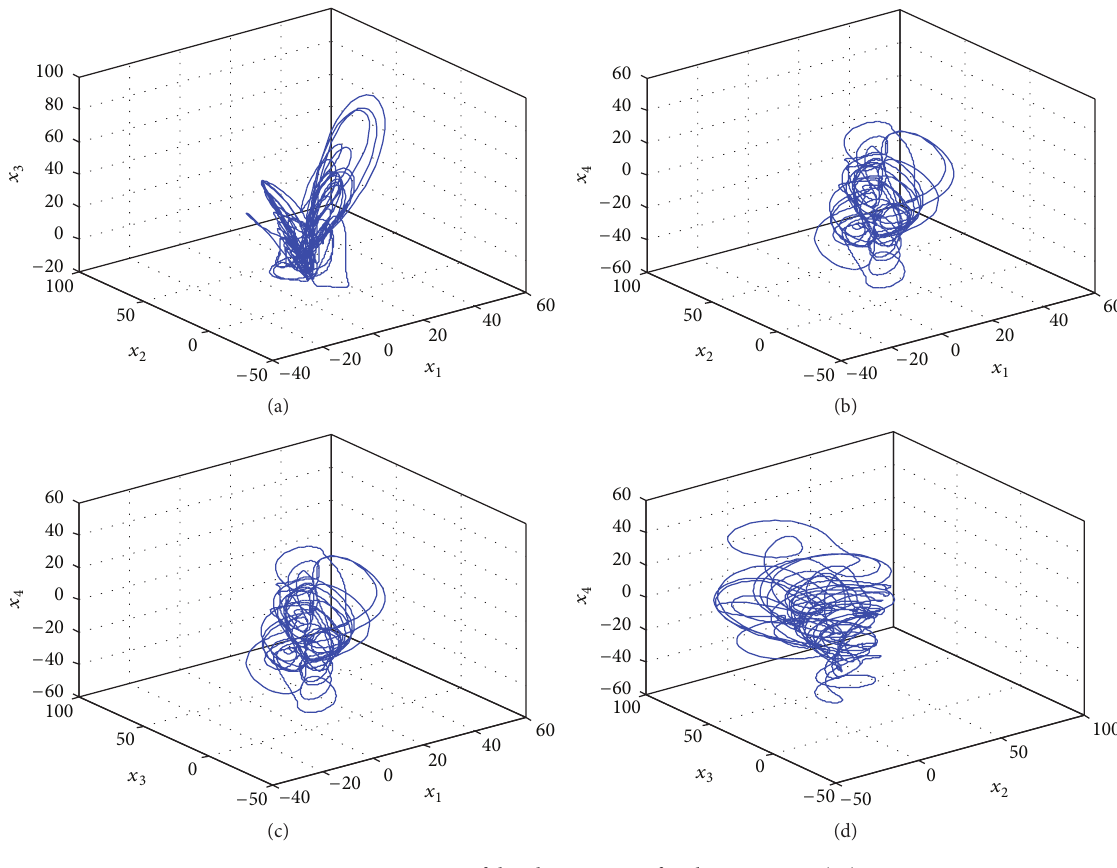
Figure 4: Projections of the phase portrait for chaotic system